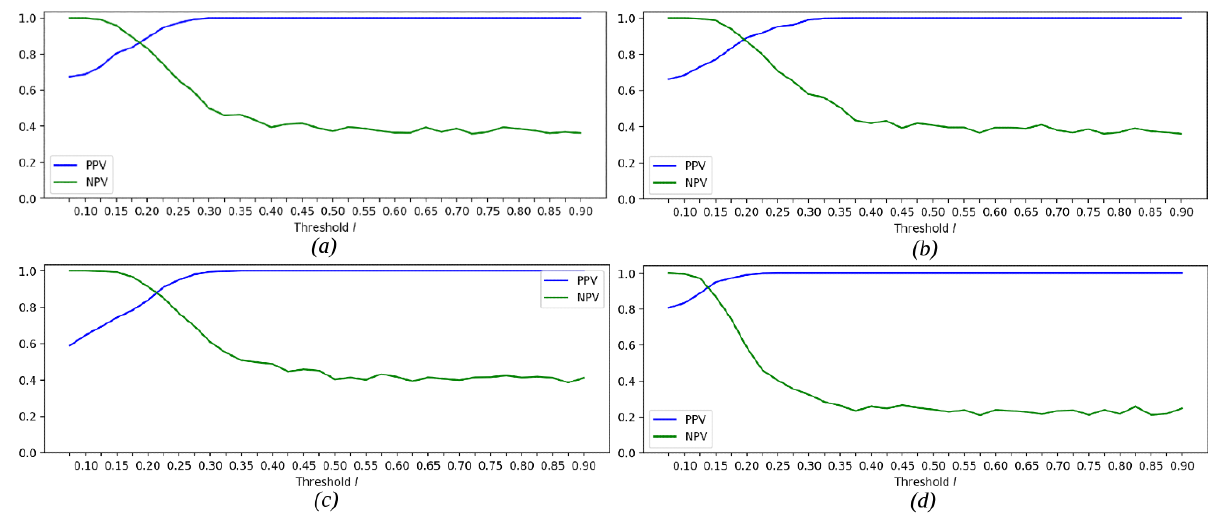
Figure 10. Positive and negative predictive values for varied minimum scaling coefficient thresholds estimated on the set of distorted images for fields: ( a ) “31.12.1981”, ( b ) “19.01.2013”, ( c ) “18.01.2028”, and ( d )